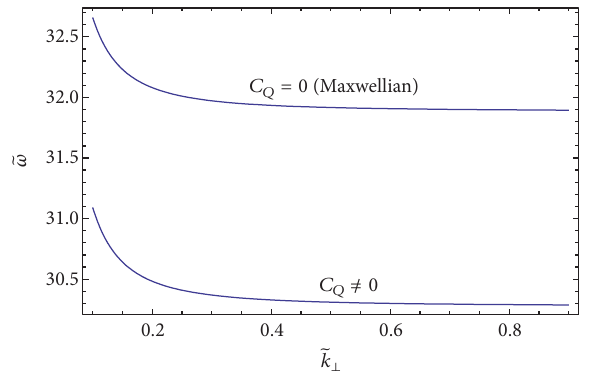
Figure 5: Effects of 𝐶 𝑄 on the real part of the dispersion